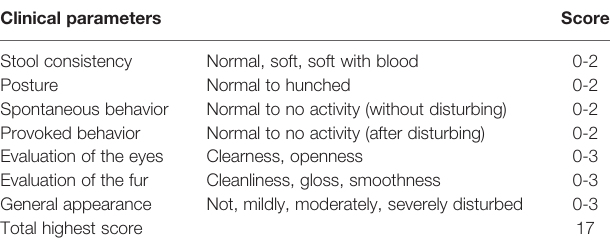
TABLE 1 | Clinical colitis scoring system